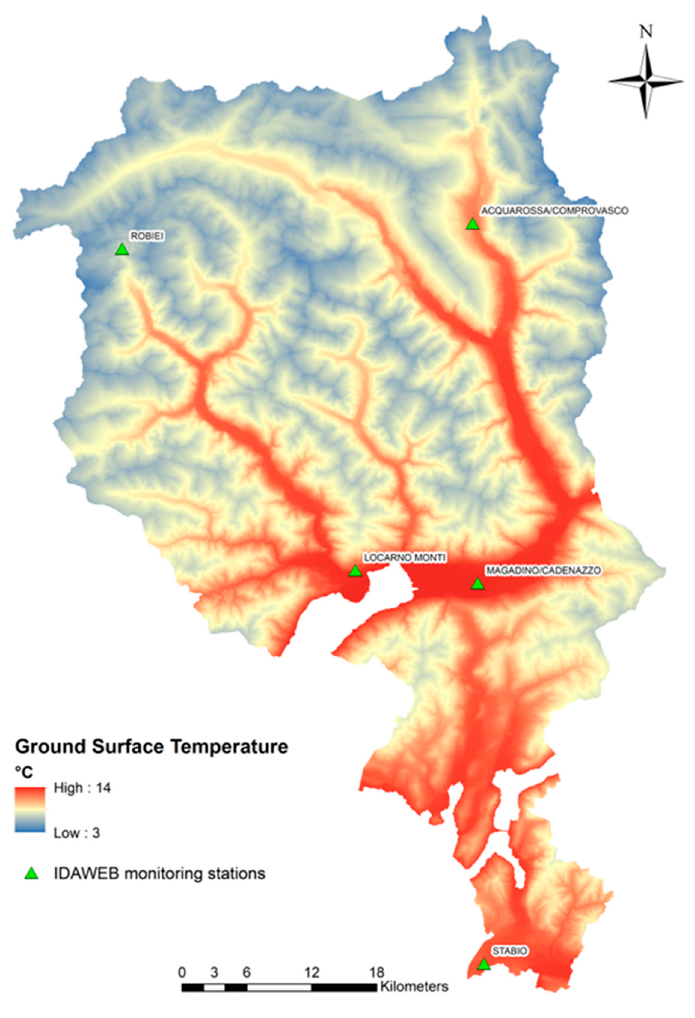
Figure 3. Map of reconstructed ground surface temperature (GST) with highlighted IDAWEB stations used for comparison between measured and estimated GST. Table 4. Comparison between measured and estimated